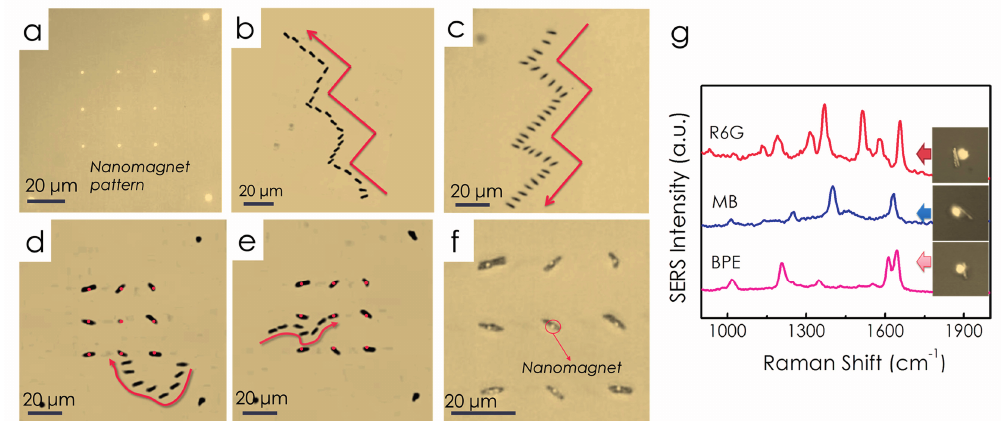
Figure 14. Nanocapsules can be precisely transported and assembled on the pre-patterned nanomagnets with electric tweezers. ( a ) A 3 × 3 nanomagnet array was fabricated by electron beam lithogaphy. With combined AC and DC E fields applied in both the X and Y directions, a nanocapsule was moved along prescribed trajectories such as “stairs”, aligning ( b ) parallel and ( c ) perpendicular to its orientation; ( d , e ) Overlapped snapshots show the delivering and assembling process of a nanocapsule onto a nanomagnet. Note the nanomagnets were highlighted in red; ( f ) An assembled 3 × 3 nanocapsules array. All the images were taken by reflective optical microscope; ( g ) From the assembled nanocapsules, various chemicals including R6G, methylene blue, and BPE have been detected. With permission from